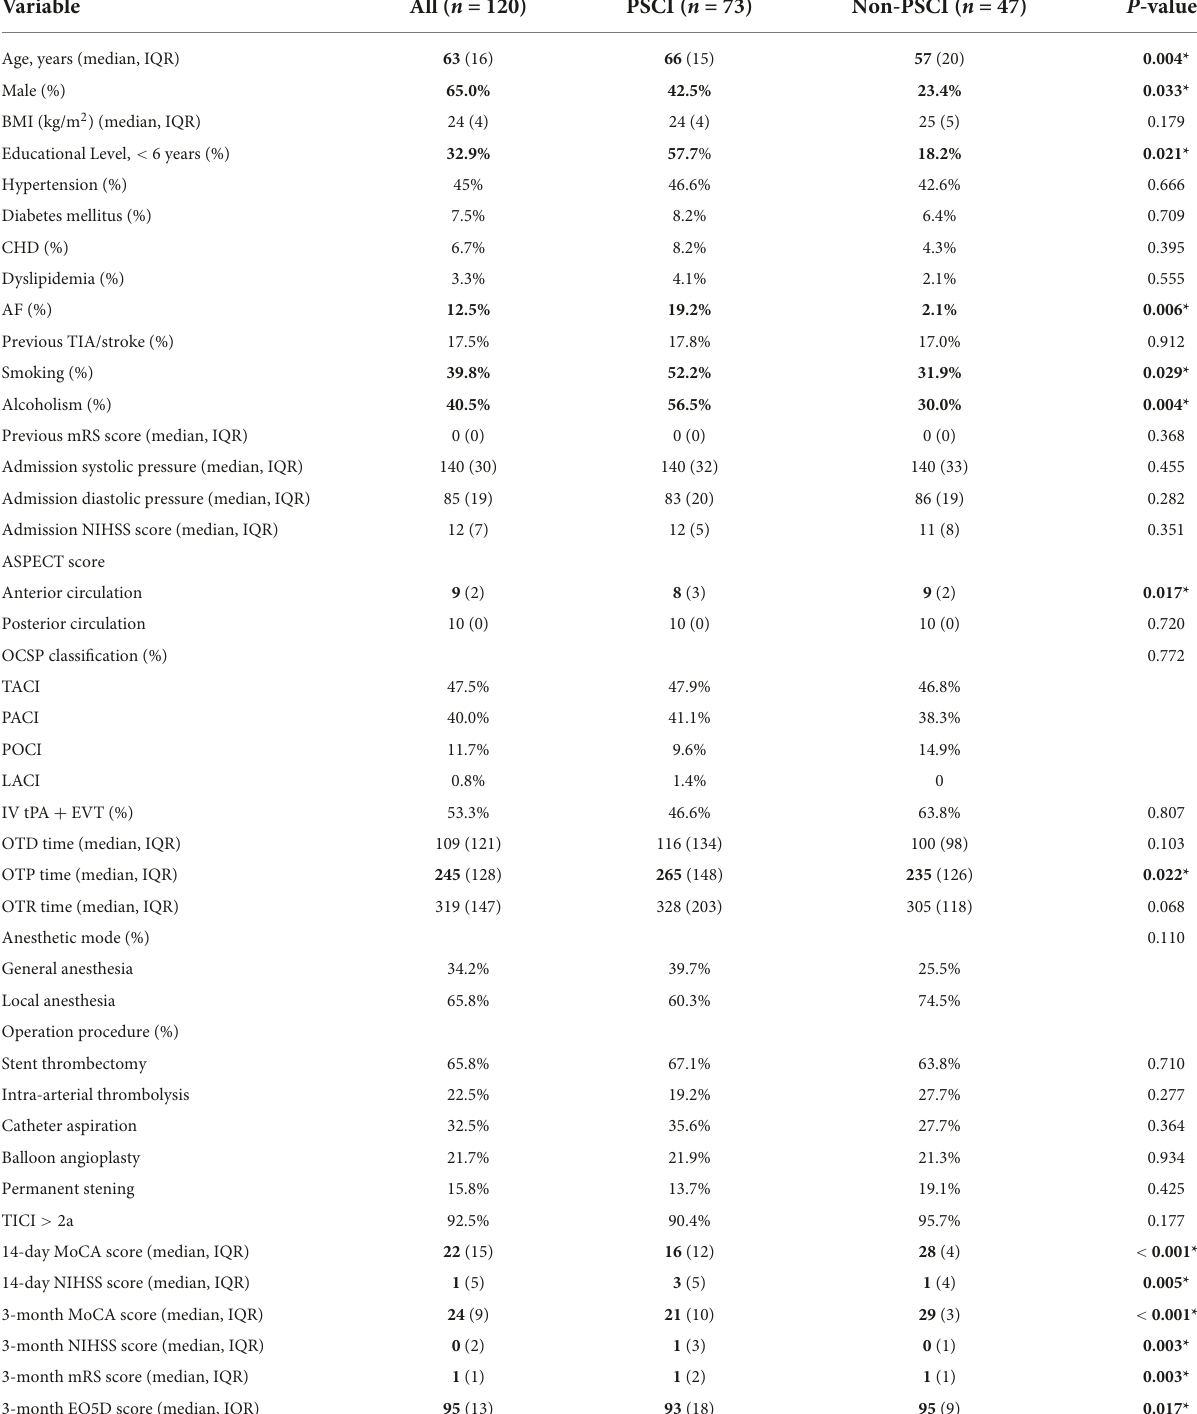
TABLE 1 Baseline demographics and clinical data of all